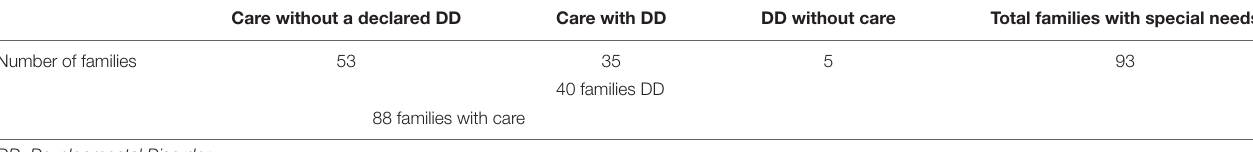
TABLE 1A | Care provided to children with and without developmental disorders (DD). Care without a declared DD Care with DD